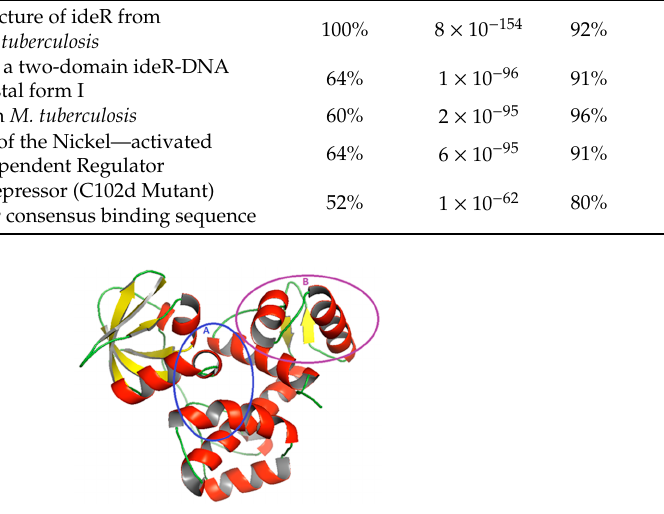
Table 1. Homologues of Mycobacterium ulcerans’ Iron-dependent Regulator (ideR). These are best 5 of 23 hits with percentage identity from 80% and above obtained from Basic Local Alignment Search Tool (BLAST).